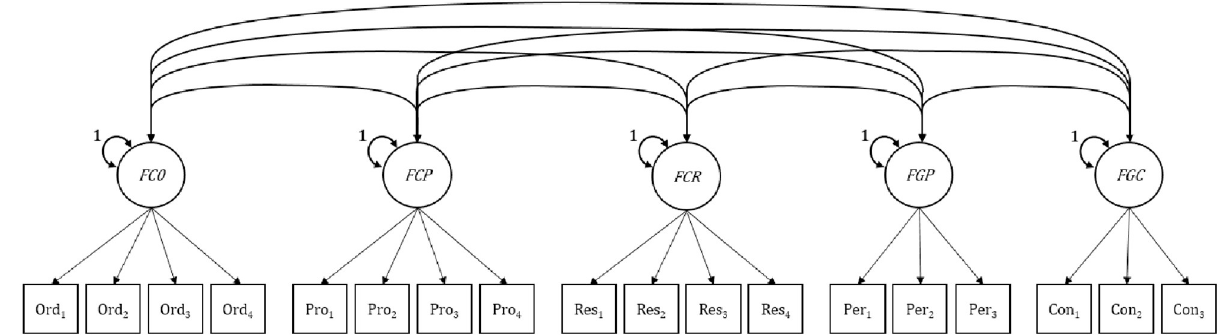
Fig 1. Correlated first-order factors model (Model A). Conscientiousness facets: FCO = Organization factor, FCP = Productiveness factor, FCR = Responsibility factor. Grit facets: FGP = Perseverance of effort factor, FGC = Consistency of interest factor. Latent acquiescence response style variable not